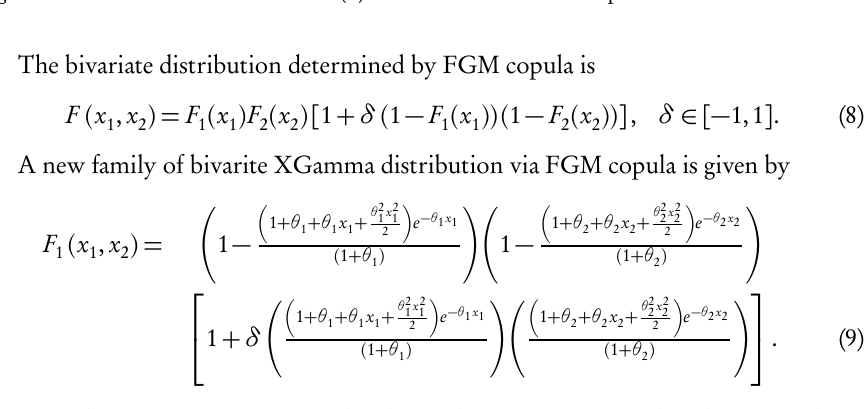
Figure 1 – Hazard rate function for XG( θ ) for different values of the parameter θ